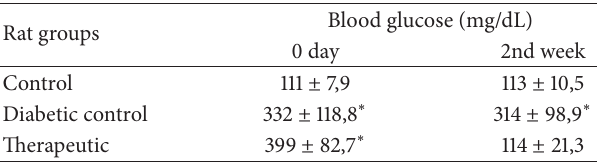
Table3:EffectofHFMEonFastingBloodGlucose(FBG)ofcontrol, diabetic, and therapeutic